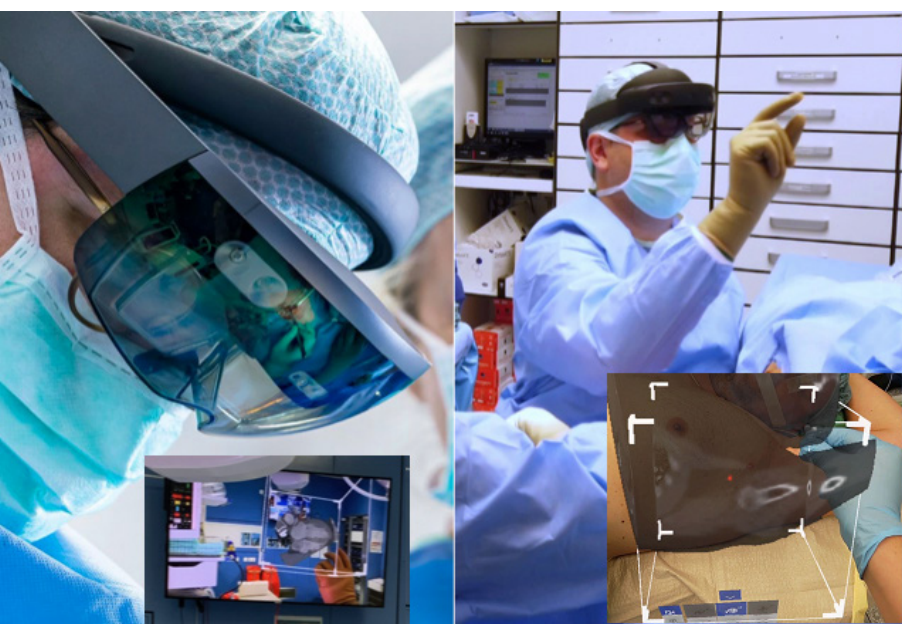
Fig. 1 - Practical implementation of the virtual reality in the surgical operating room.